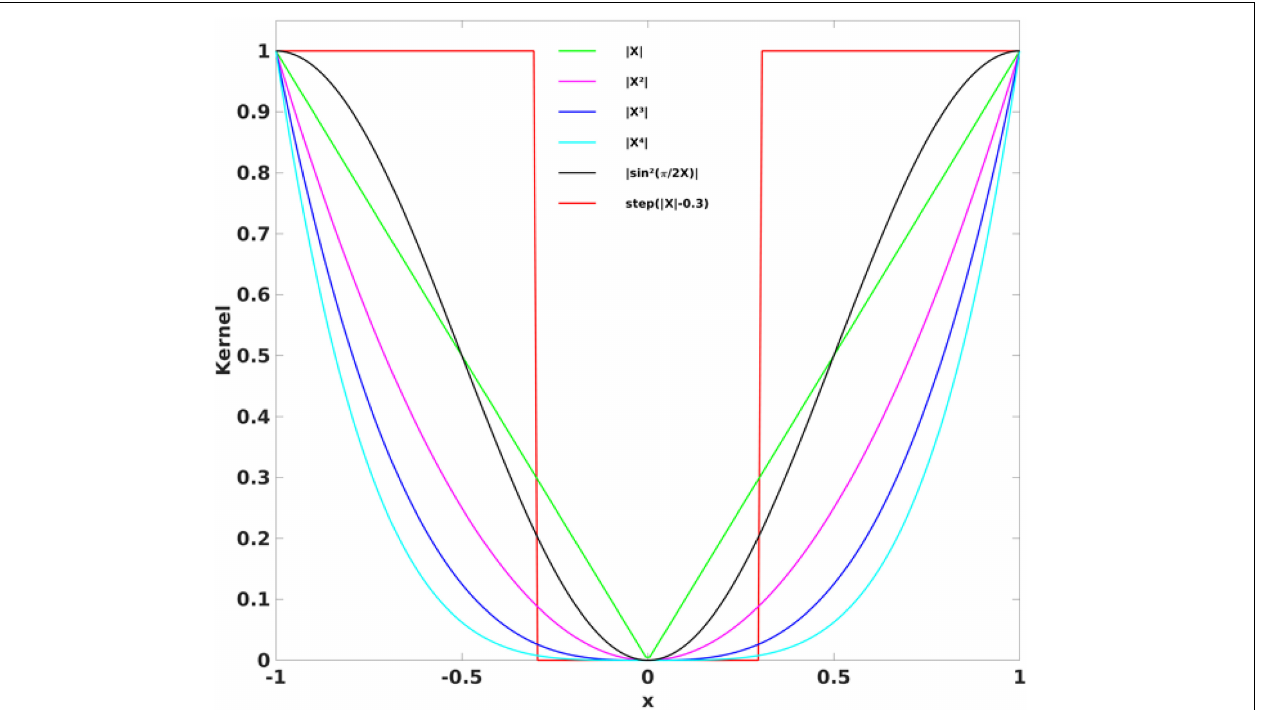
FIGURE 2 | The six different kernel functions investigated in the study to derive the CDI P and CDI N metrics. The widely used threshold method can be considered as the case for the square-well kernel function (k 6